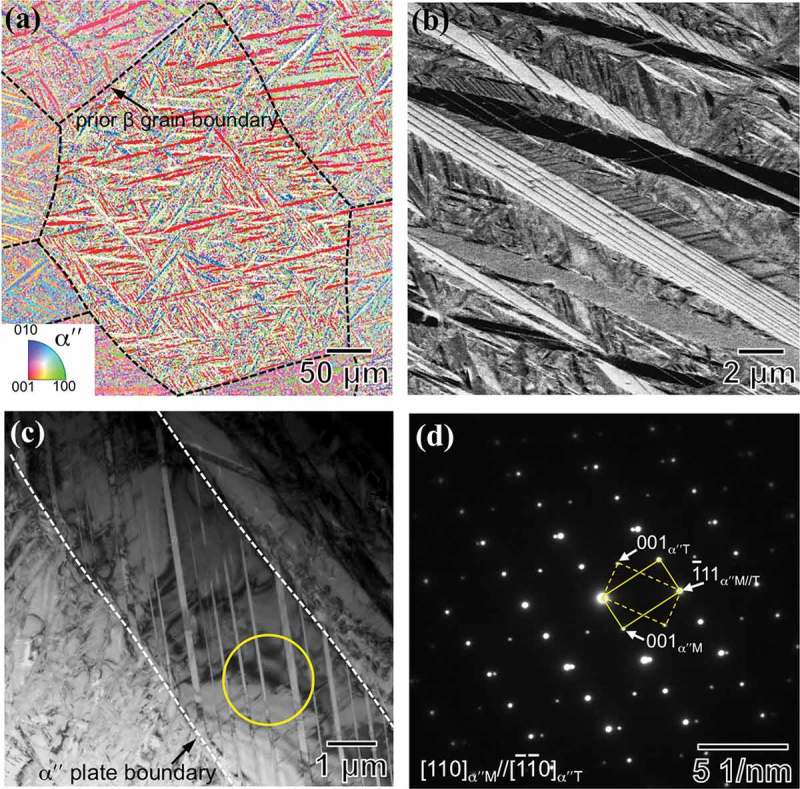
(a) Inverse pole figure (IPF) map of the as-quenched microstructure with dashed lines indicating the prior β grain boundaries. (b) Backscattered electron (BSE) image showing the acicular αʺ plates. (c) TEM image of αʺ martensite with internal twinning structure. (d) Selected area electron diffraction (SAED) pattern of the circled area in (a). The reflections connected by the yellow solid and dashed lines originate from matrix and twin, respectively. The subscripts ‘M’ and ‘T’ denote matrix and twin, respectively.